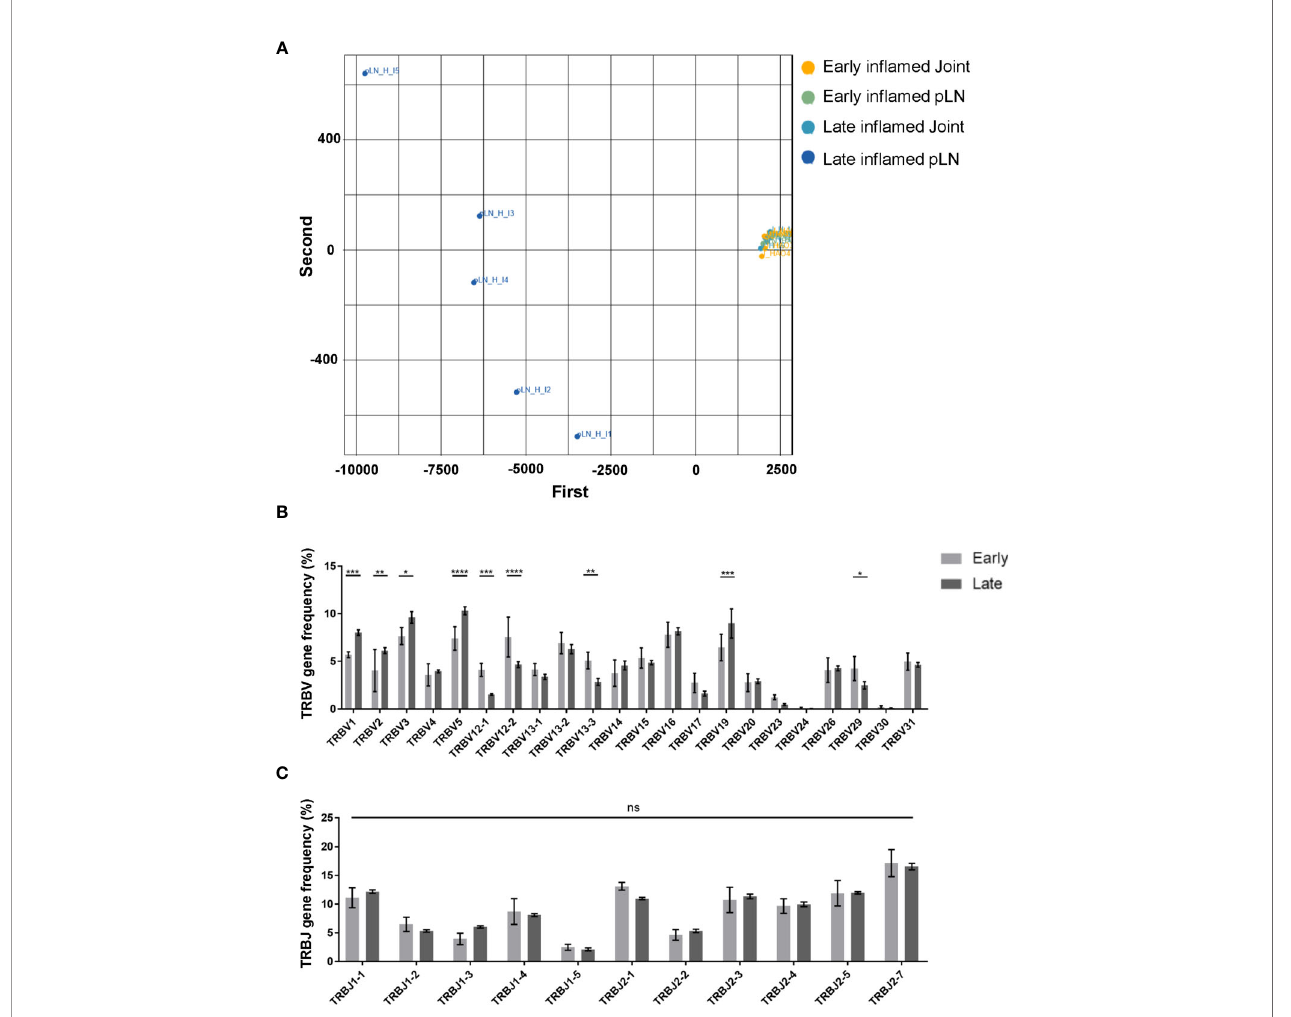
FIGURE 5 | Range of TRBV genes expressed in antigen experienced endogenous CD4 T cell repertoires of in fl amed pLNs and joints at the early and late phases. (A) PCA plot of TRBV gene frequency in repertoires of in fl amed pLNs and joints at the early and late phases. Frequency of (B) TRBV gene expression, and (C) TRBJ gene expression in in fl amed pLNs at the early and late phases. Graphs represent 1 experiment with n=5 for both the early and late in fl amed groups. Groups were compared using ordinary 2-way ANOVA with Sidak ’ s multiple comparisons test. Data presented as mean ± SD. Stars represent the following p values: *<0.05; **<0.01; ***<0.001; ****<0.0001; ns, not signi fi